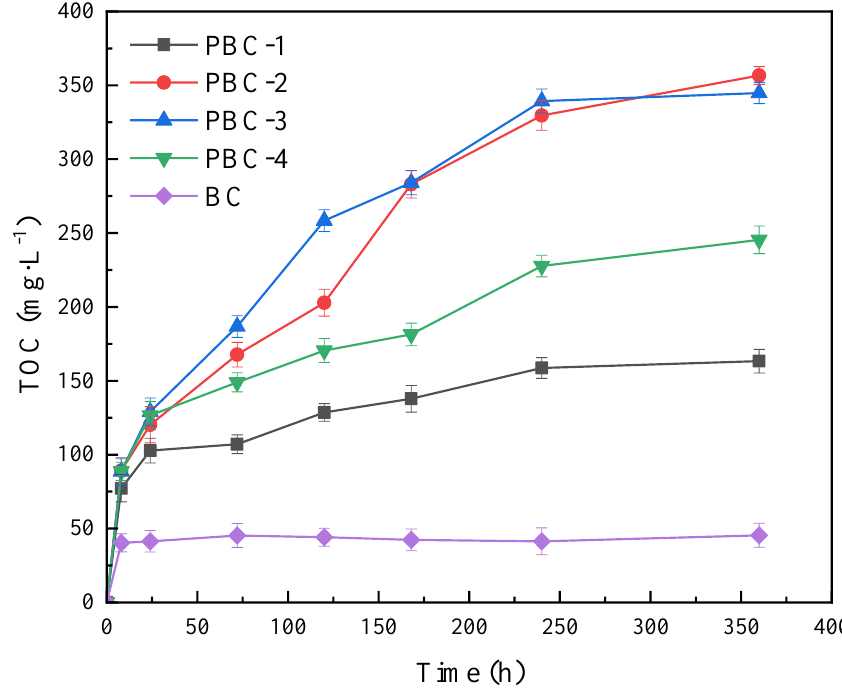
Figure 4. Carbon − releasing performances of BC and PBCs in sterile pure water. Figure 4. Carbon−releasing performances of BC and PBCs in sterile pure water.